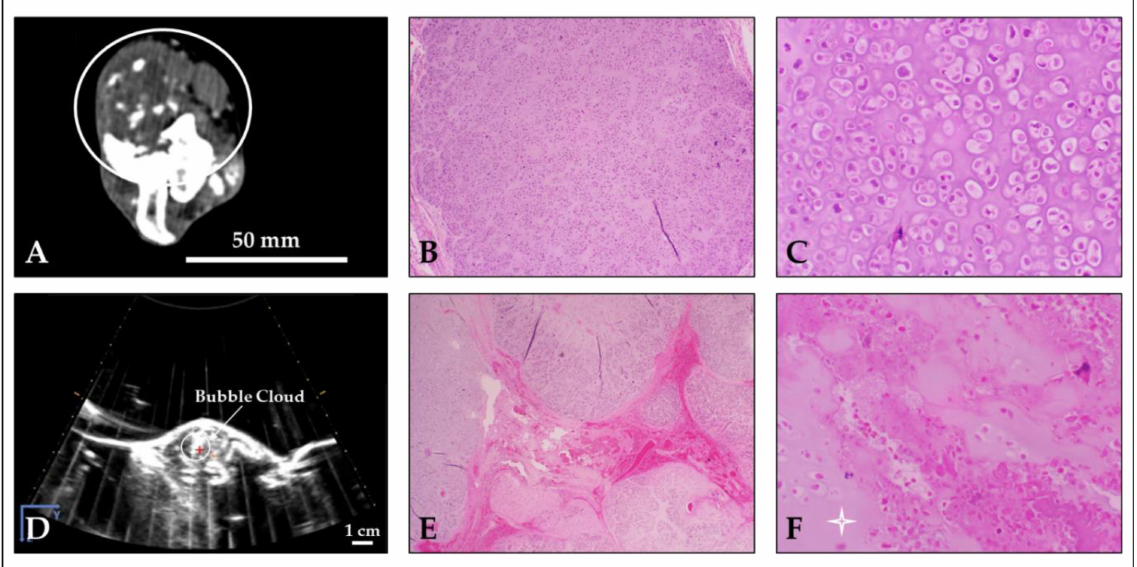
Figure 4. Representative images of chondrosarcoma histotripsy treatment (Patient #9). ( A ) Pre- treatment CT scan with tumor circled. ( B , C ) Untreated tumor tissue showing neoplastic chondroblasts surrounded by chondroid matrix ( B : magnification—4 × ; C : magnification—20 × ). ( D ) Histotripsy bubble cloud on US imaging during treatment. ( E , F ) Treated tumor tissue exhibiting acute hem- orrhage, a mixture of dead or dying cells, and degeneration of the chondroid matrix (white star) ( E : magnification—2 × ; F : magnification—20 ×